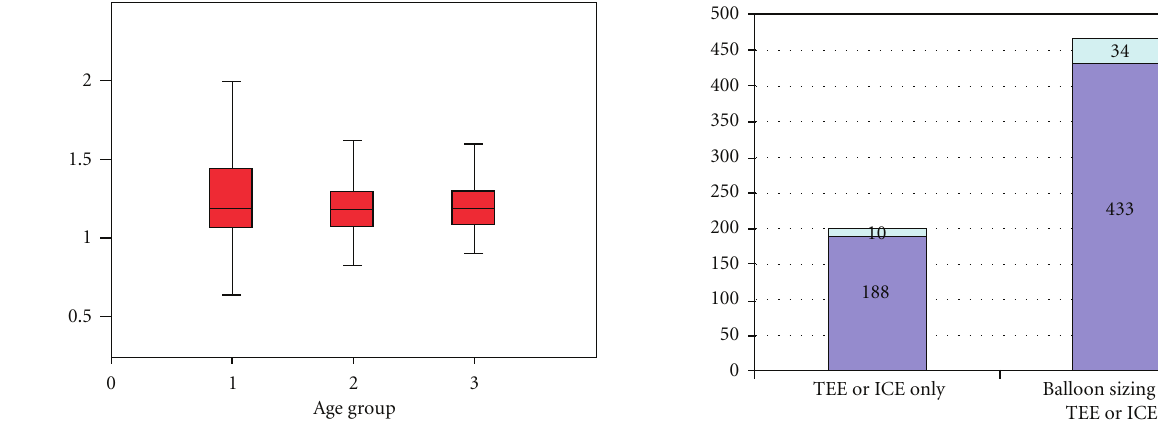
Figure 2: Device/diameter ratio for ASD in successful procedures among the age groups ( n = 621), age group 1 = children and adolescents ( < 18 years of age; n = 169), age group 2 = young to middle-aged adults (18–50 years of age; n = 315), and group age 3 = older adults ( > 50 years; n = 137).